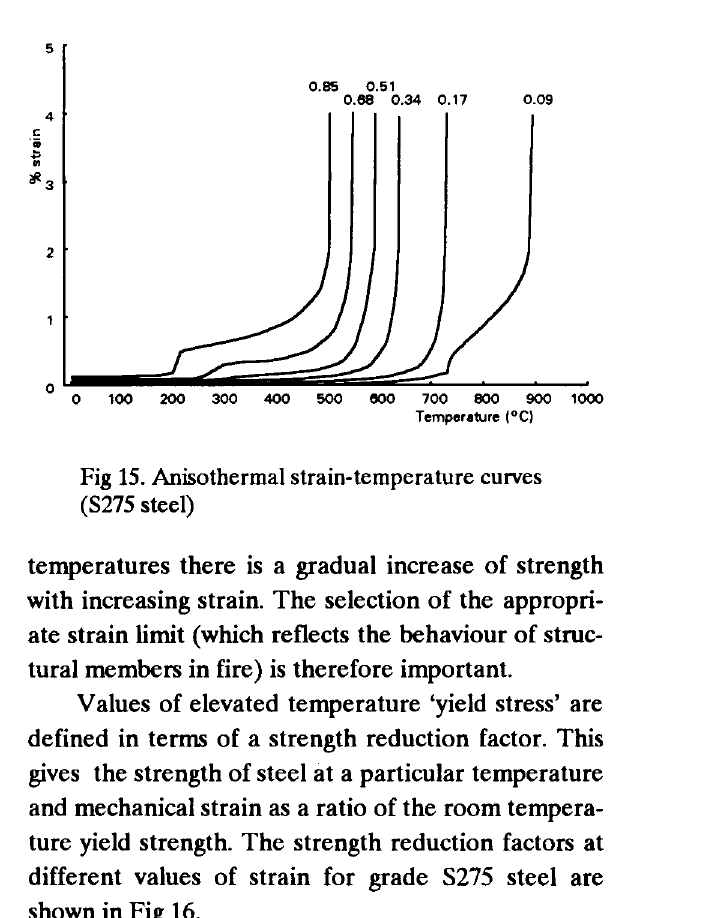
Fig 14. Isothermal stress-strain curves (S275 steel) Anisothermal or transient tests where developed more recently for generating material data for fire engineering [10). In these tests, the specimen is sub ject to constant load and the rate of heating is set at a pre-determined level (typically 10°C/minute ). The resulting strains are measured and the effect of ther mal strains is deducted using 'dummy' unloaded specimens subject to the same temperature condi tions. An example of the resulting strain-temperature curves is shown in Fig 15 for different values of initial applied stress. Stress-strain curves at a particular temperature are obtained by interpolation from a family of strain-temperature curves at different stresses. Anisothermal tests result in slightly lower strengths than isothermal tests for carbon steel. The difference diminishes with increasing strain levels (> 1%).